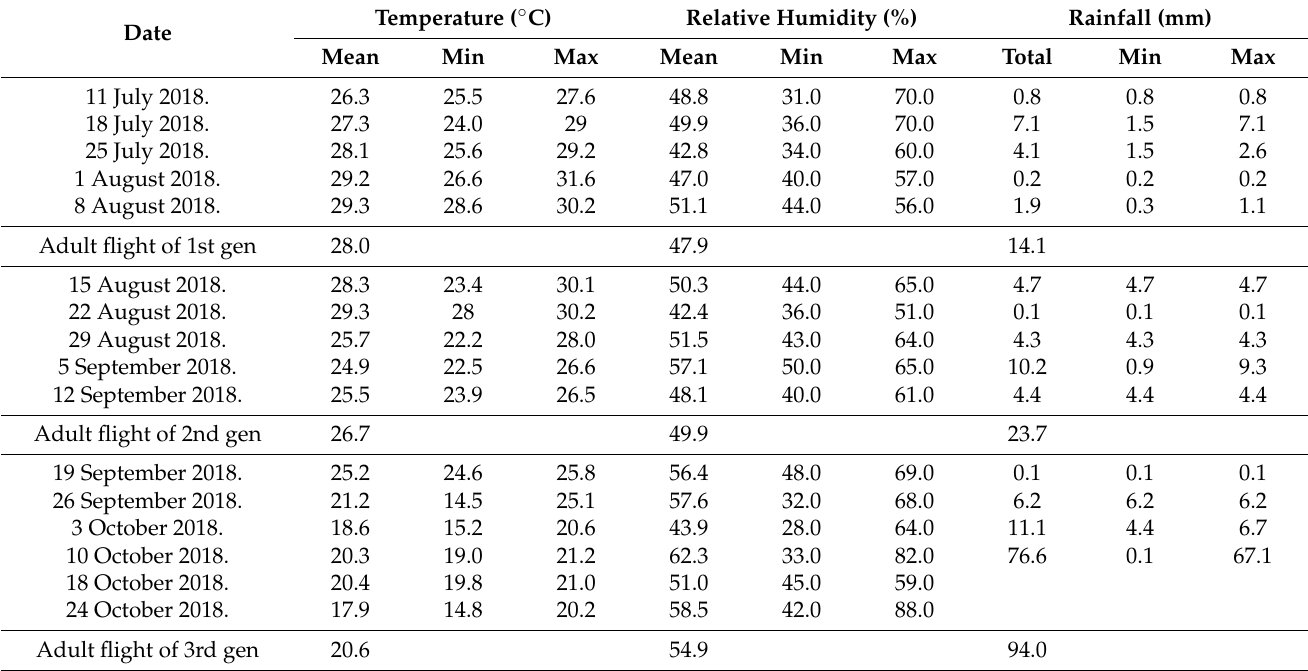
Table 1. Climatic parameters data during the investigation.